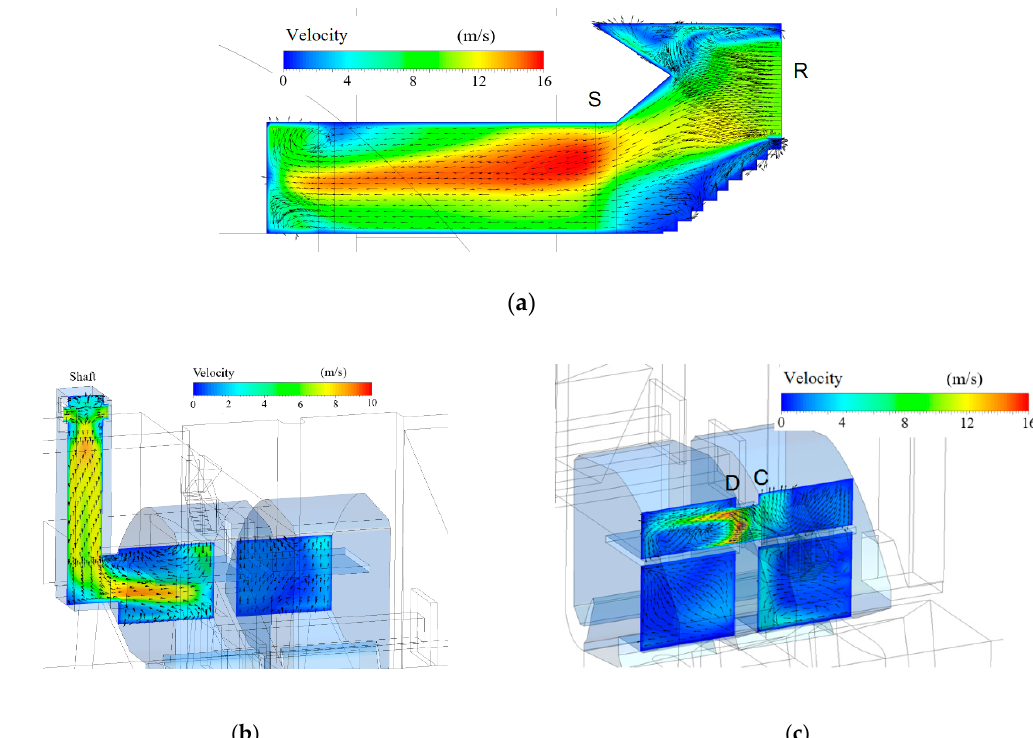
Figure 11. Case 1, air-flow patterns colored by velocity magnitude: ( a ) along the gallery’s center plane; ( b ) along the shaft’s center plane (parallel to dam axis); ( c ) along vertical plane through the centroids of door openings C and D.